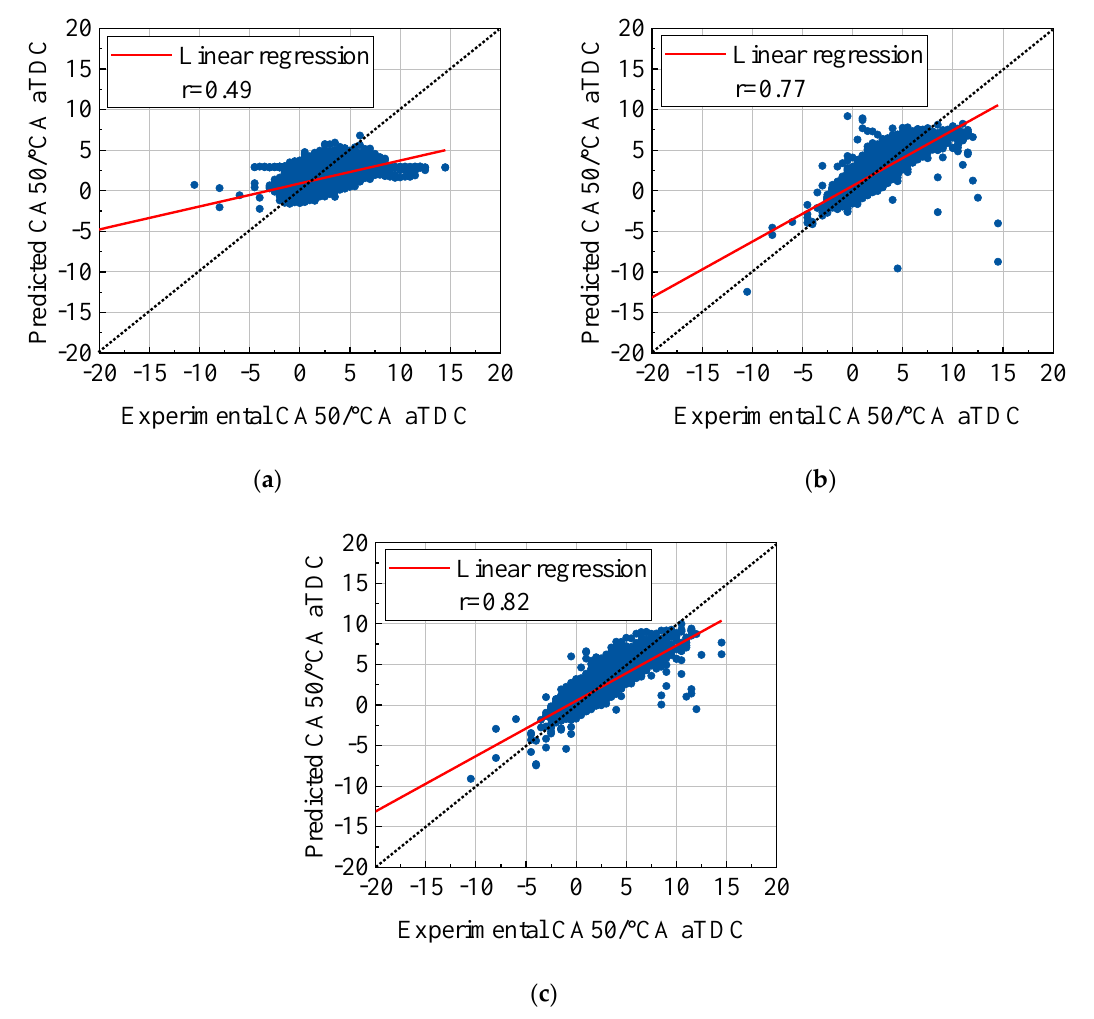
Figure 15. Comparison of predicted CA50 and experimental CA50: ( a ) ANN IC ; ( b ) ANN CP ; ( c ) ANN IP .